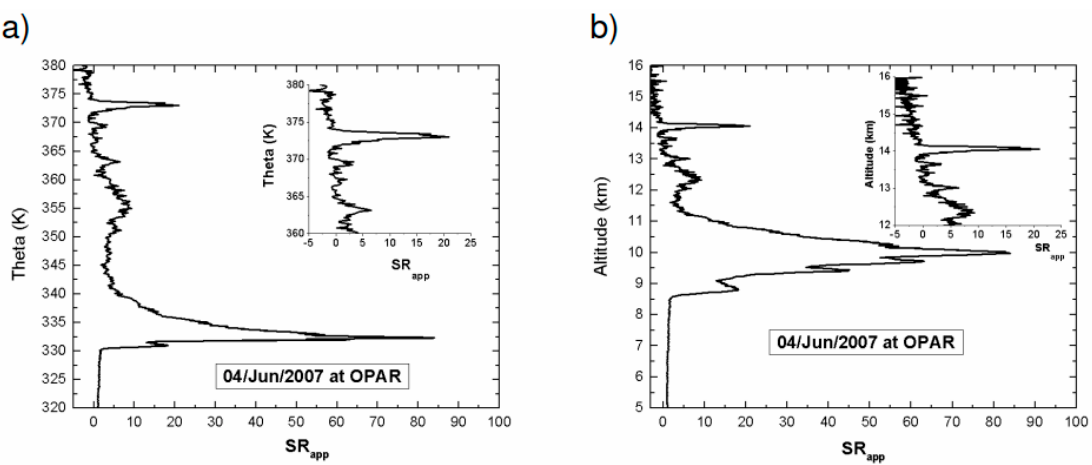
Figure 2. SR app profile observed by the lidar at Maïdo on 4 June 2007 at ~16h 50 UTC, according to the potential temperature (from ECWMF-ERA-Interim (Dataset of global atmospheric reanalysis stated as European Centre for Medium-Range Weather Forecasts Re—Analysis continued since 1979)) ( a ) and the corresponding altitudes ( b ).